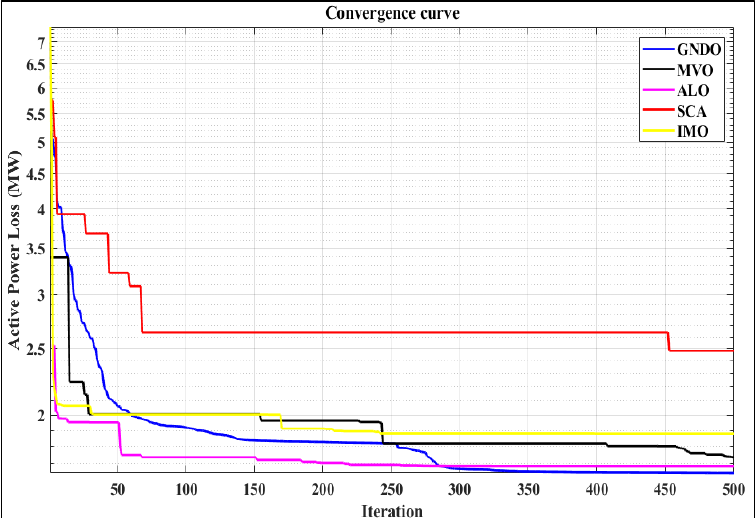
Figure 14. Convergence characteristics of APL minimization.